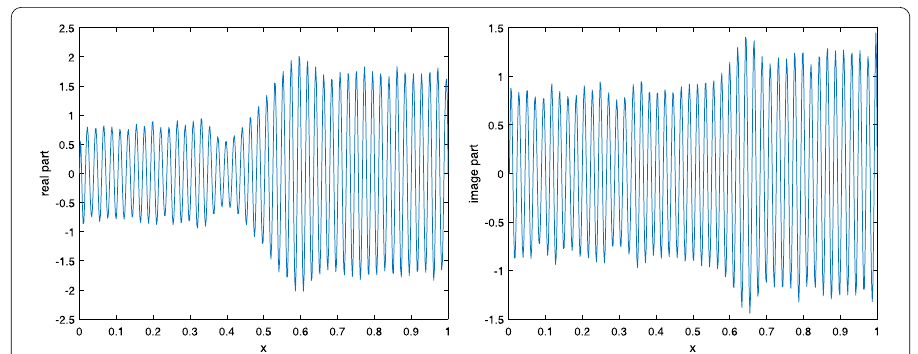
Figure 3 Real and image parts of the solution at the line y = 1/4 with k = 128 π , N = 512